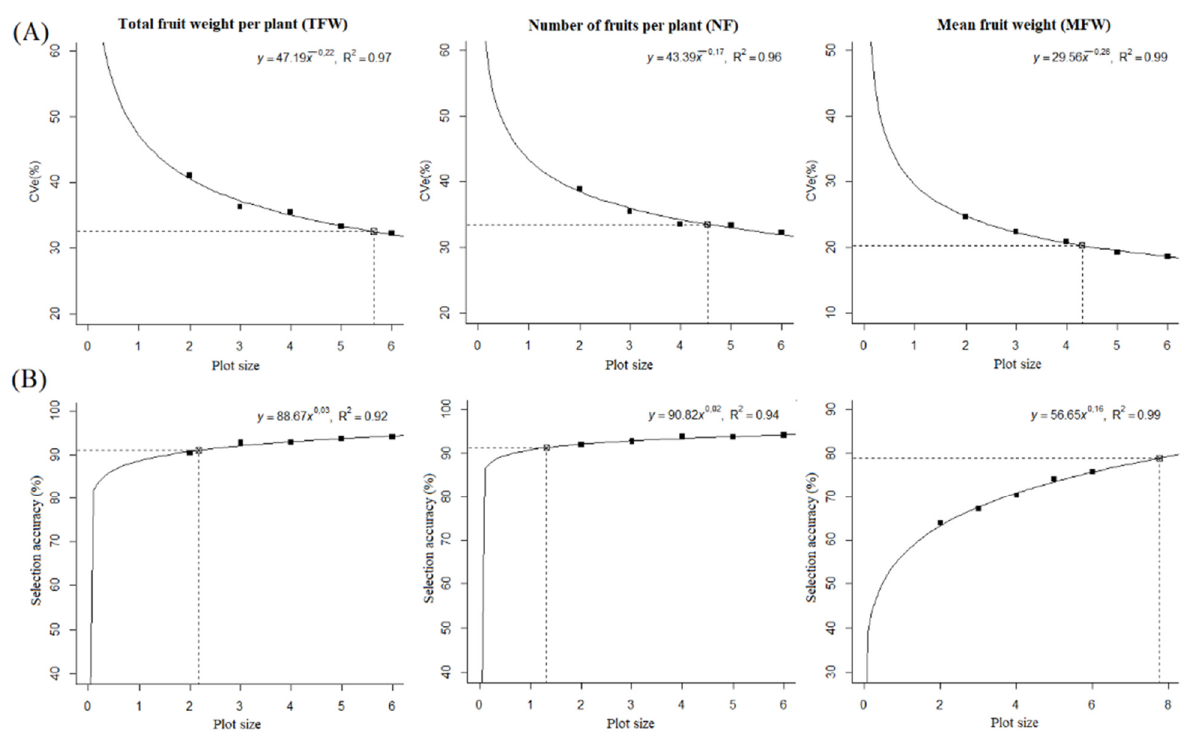
Figure 4. Coefficient of experimental variation—CVe ( A ) and selection accuracy ( B ) by the modified method of maximum curvature as a function of different plot sizes for experiments with “pimenta- de-cheiro” Capsicum chinense . The squares represent the points that generated curvature (equation). The meeting of the dashed lines represent the points of maximum curvature.